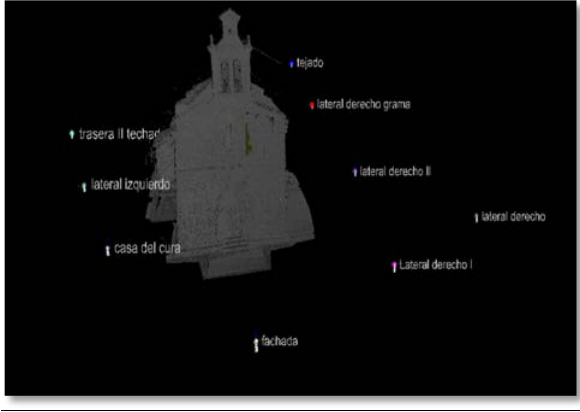
Figure 4. The dimensional